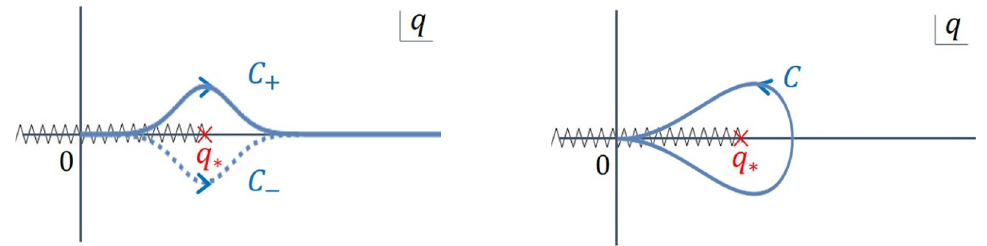
Figure 4 . Contours C (cid:6) and C . q (cid:3) is the singular point of where the contours C are displayed in (cid:12)gure 4. The details of the derivation are (cid:7)